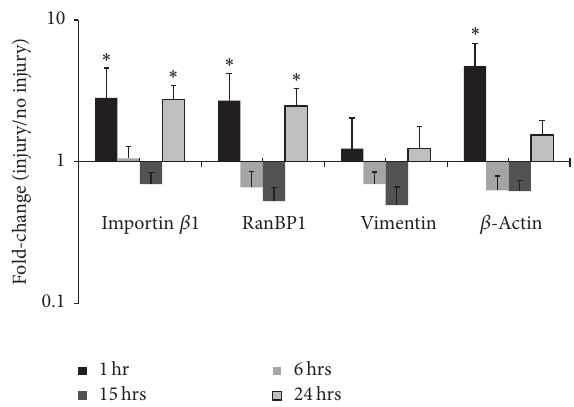
Figure 2: Axotomy results in biphasic axonal increase of RIS- associated transcript levels. Real-time RT-PCR was used to quantify levels of putative RIS-associated mRNAs and 𝛽 -actin in axons after axotomy. All values are displayed relative to uninjured controls. Sig- nificant increases in importin 𝛽 1, RanBP1, and 𝛽 -actin mRNA levels at 1 hour after axotomy, suppression at 6 and 15hrs after axotomy, and increases again at 24 hours after axotomy for importin 𝛽 1 and RanBP1 were observed. No significant changes were observed in vimentin transcript levels. Error bars represent standard deviations. ∗ indicates significant difference from control ( p < 0.05) based on pairwise fixed allocation test. 𝑁 = 3 for 1 and 24 hrs, and 𝑁 = 4 for 6 and 15